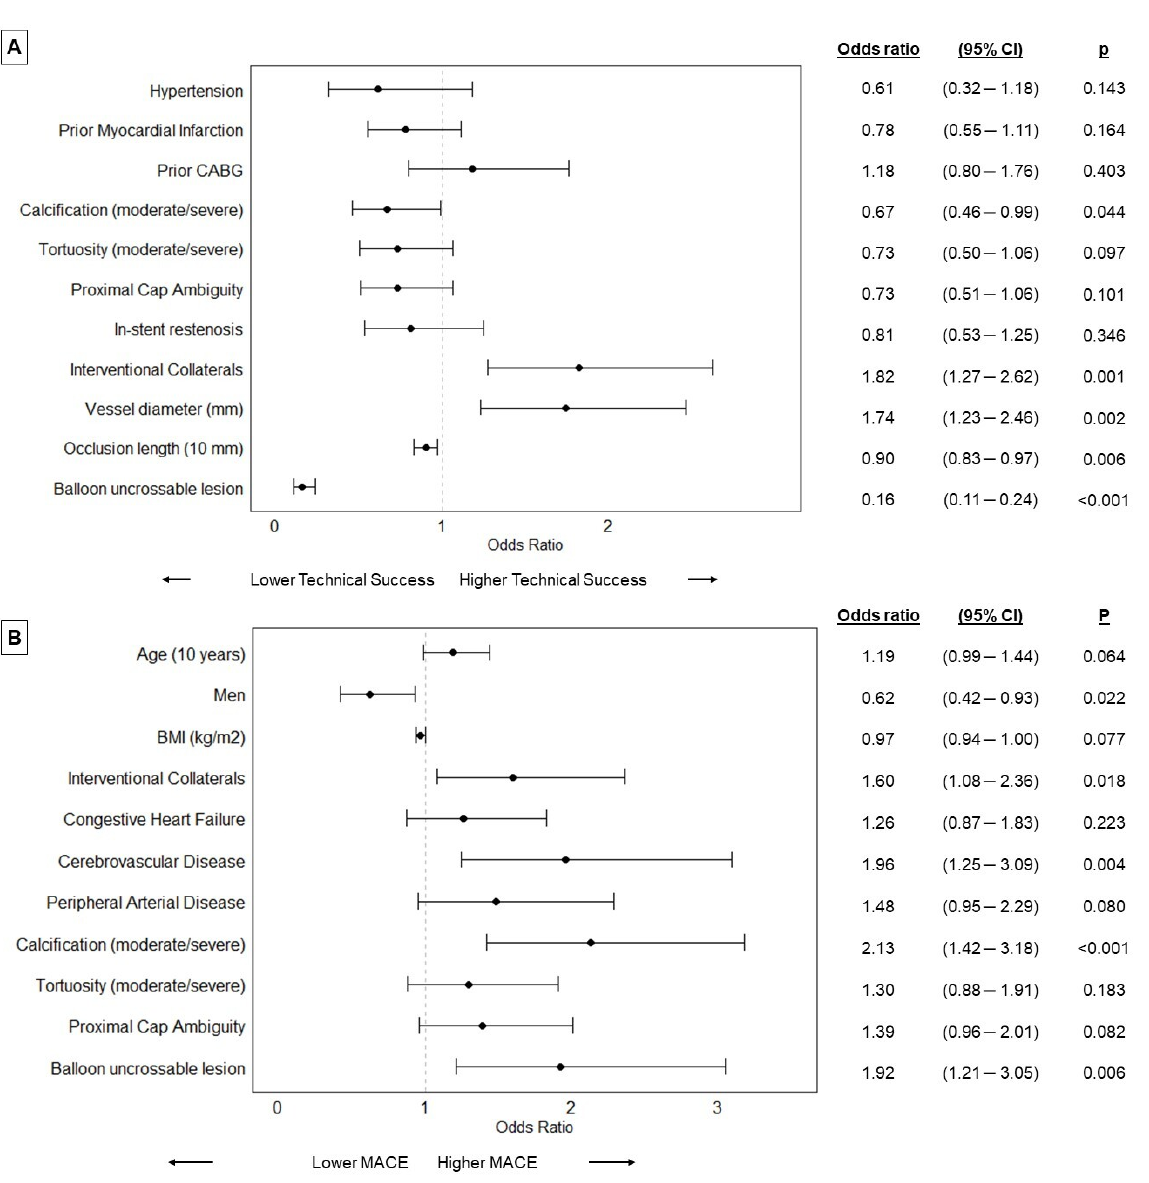
Figure 3. Forest plots representing the results of the multivariable analyses on technical success ( A ) and major cardiac adverse events (MACE, ( B )) (Dots represent odds ratios, BMI: body mass index; CABG: coronary artery bypass grafting; CI: confidence interval; MACE: major cardiac adverse events).